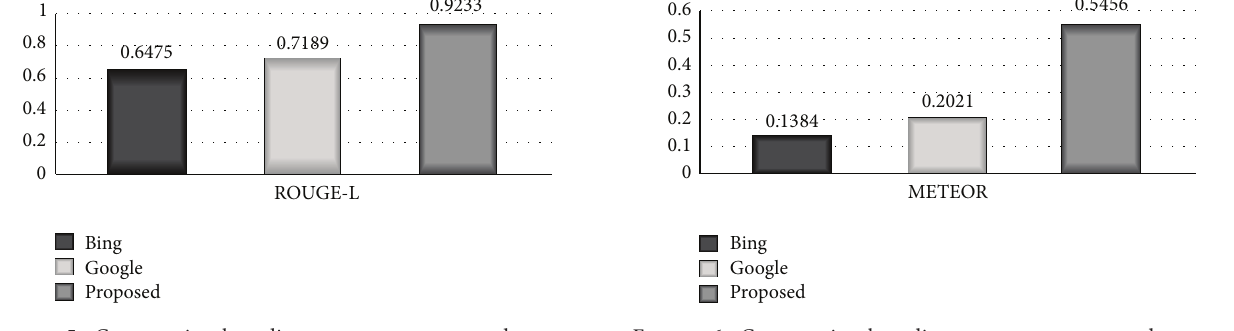
Figure 6: Comparative bar diagram among proposed system, Google, and Bing based on METEOR